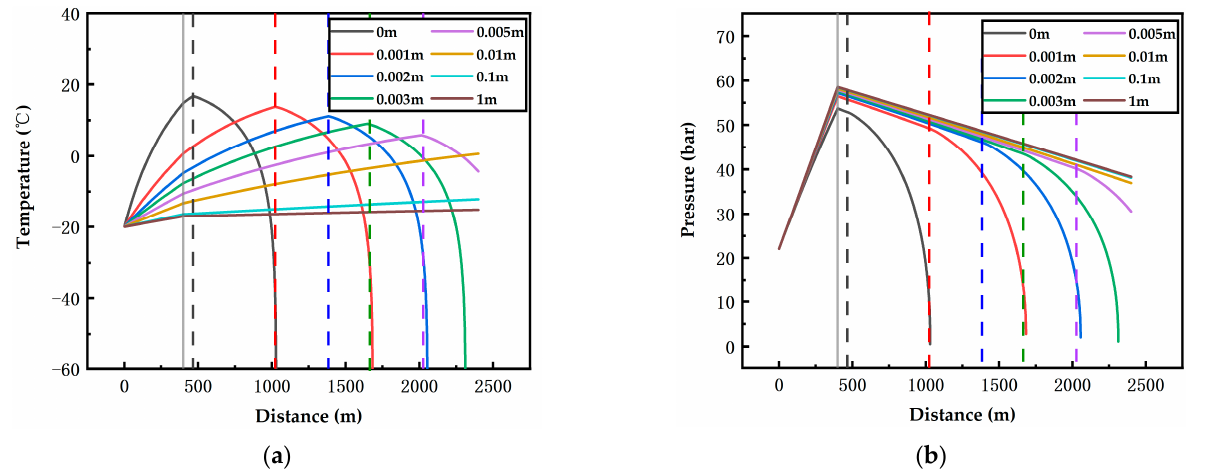
Figure 14. Effects of pipelines with different insulation thicknesses on the temperature ( a ) and pressure ( b ) of CO 2 along the pipeline at 15 m/s airflow velocity, 40 °C ambient temperature and 400 m depth (grey solid line: the connection position of the vertical pipeline and the underground horizontal pipeline; colorful dotted lines: the gasification starting positions).